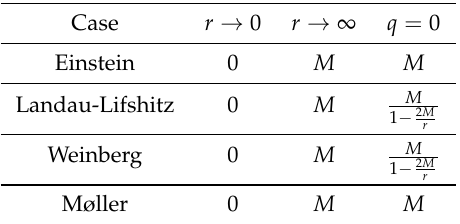
Table 1. Limiting